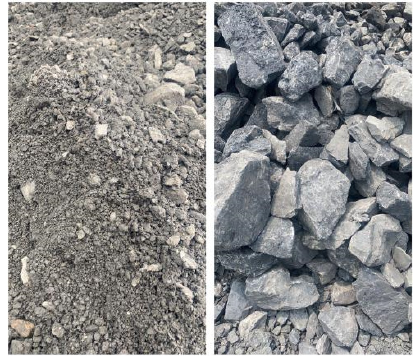
Figure 1. Separation of coal gangue.